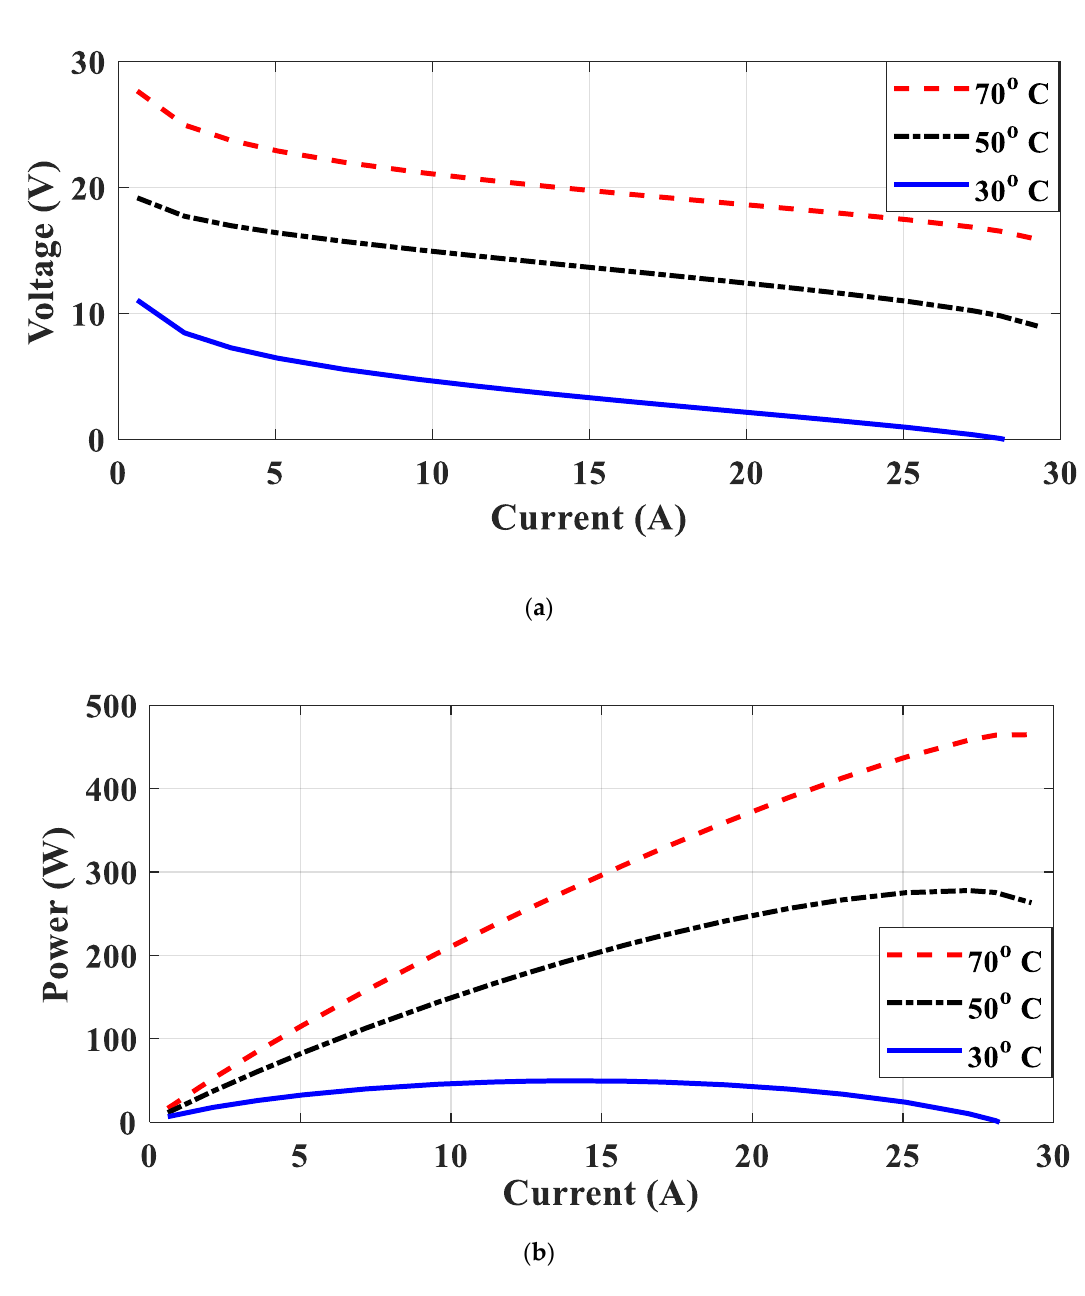
Figure 8. Polarization curves of BCS fuel cell using the HGS algorithm under various temperature conditions at constant pressure. ( a ) I–V curves. ( b ) I–P curves.